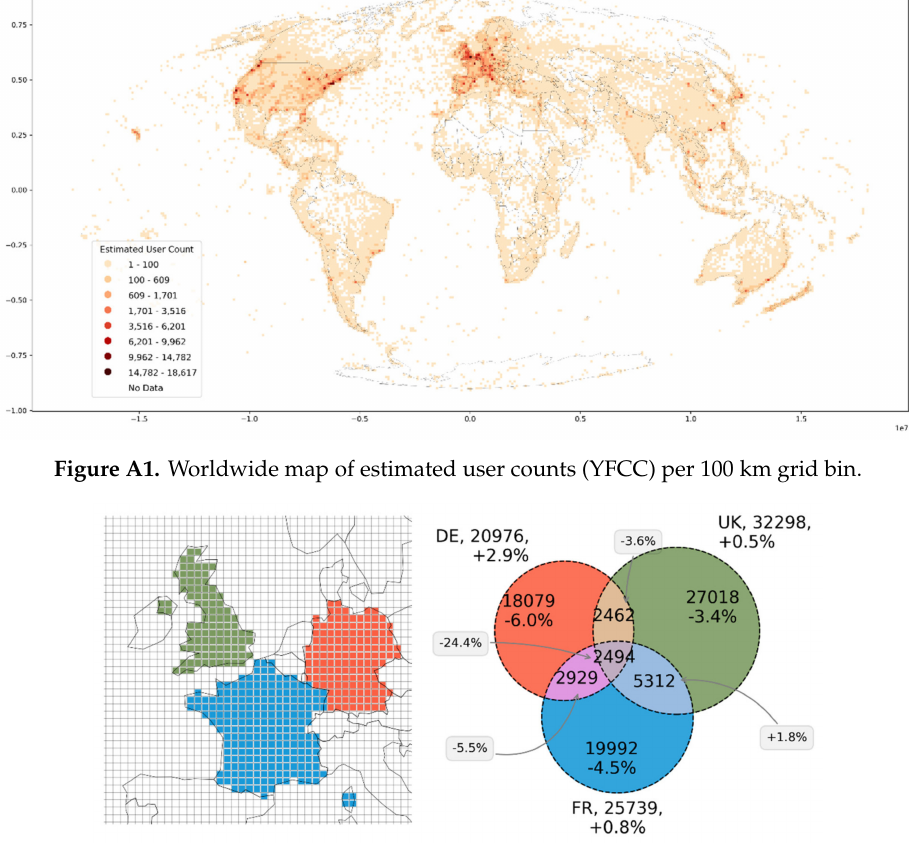
Figure A2. Figure 7 generated with 50 km grid size parameter and corresponding error